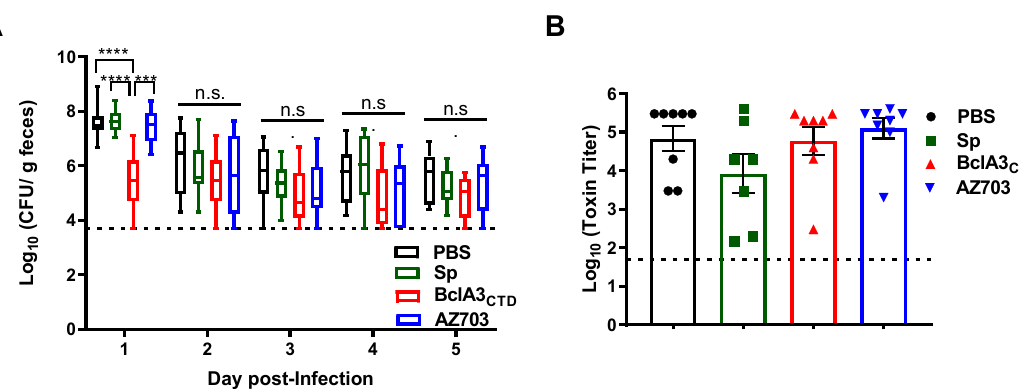
Figure 6. Analysis of spore load in feces and cecal toxin titers. ( A ) The load of C. difficile spores in the feces was evaluated on the following 5 days after infection as log 10 Colony Forming Unit (CFU)/g of feces. ( B ) The cecum content toxicity was measured and represented as log 10 toxin titer. Two-way ANOVA Tukey’s multiple comparisons test in A and Mann–Whitney non-parametric tests in B were used; Statistical differences ( p < 0.05) are indicated by asterisks. *** p < 0.001 and **** p < 0.0001. The bars are the geometric mean ± standard error of the mean. No significance (n.s).